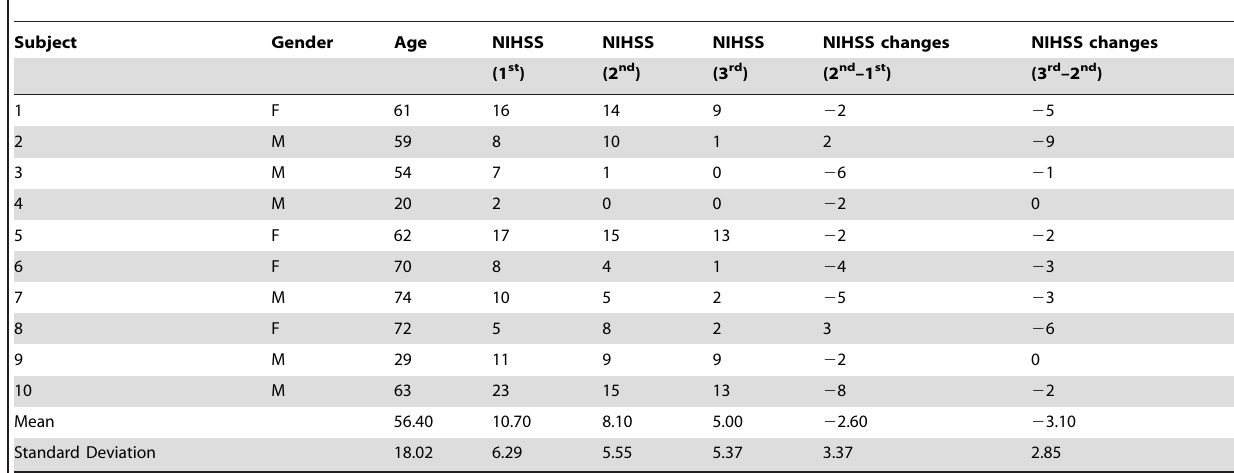
Figure 3. Phase profiles over the SWI filtered phase images corresponding to the three MRI scans (a) , 24 hours, (b) 2–3 weeks after stroke, and (c) 2 months after the onset of stroke. Table 1. List of the ten patient’s age and their assessments of NIHSS at the three MRI scans.